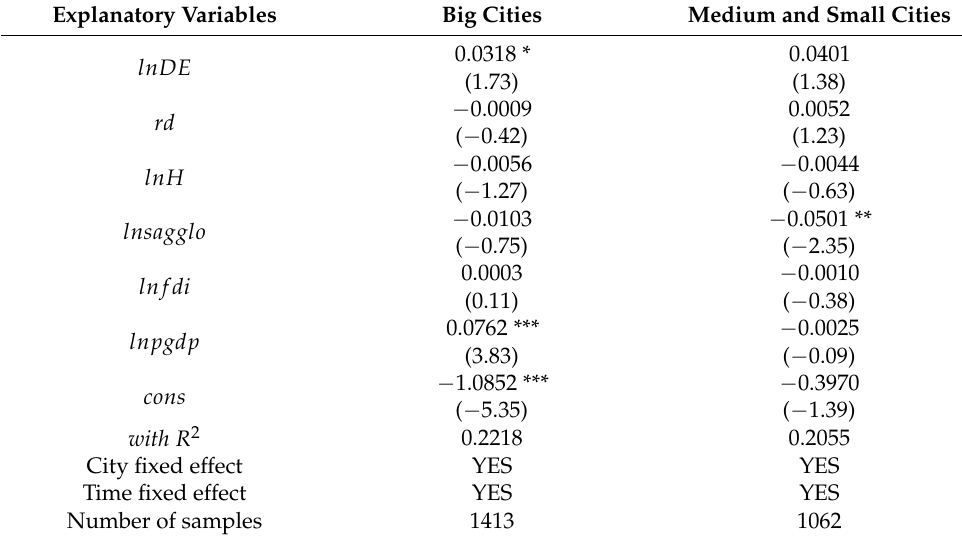
Table 8. Test results of urban scale